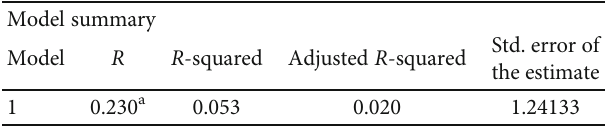
Table 7: Regression summary. Model summary